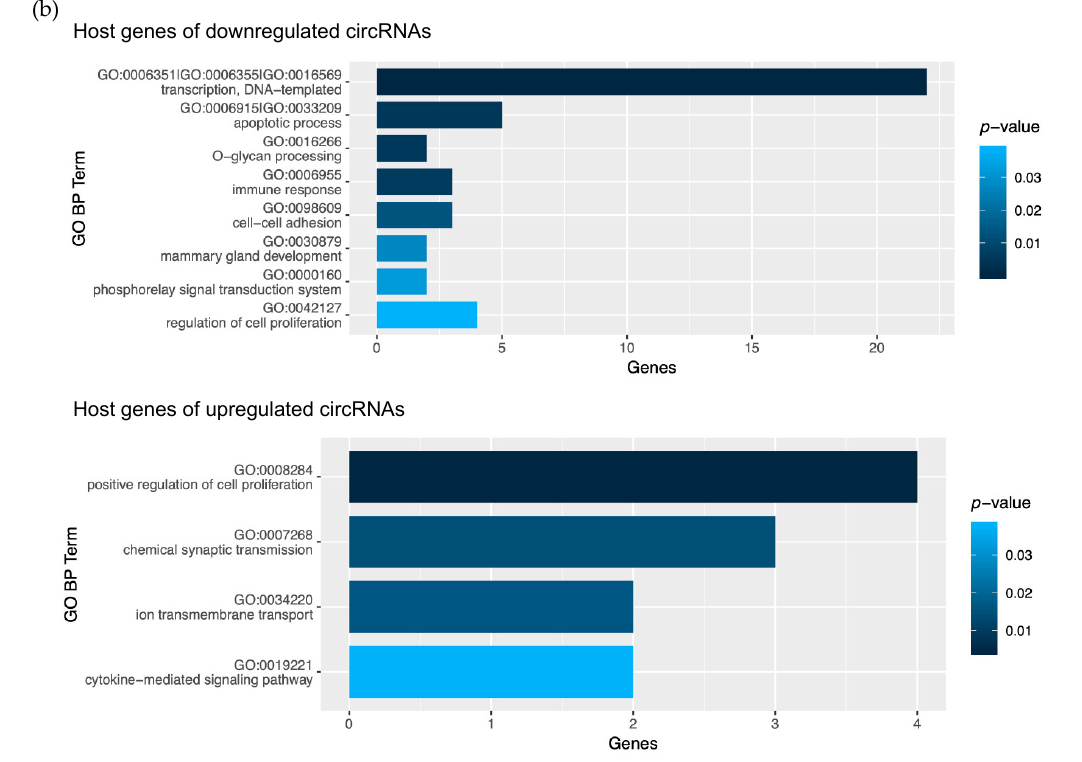
Figure 2. Effect of FUS mutation on circRNA production in mature motor neurons. ( a ) Scatter plot showing the change in the expression of circRNAs (x-axis) and their cognate linear RNAs (y-axis) in FUS P525L MNs with respect to FUS WT MNs. The distributions of the log2 fold change (FC) values are shown above and aside the scatter plot. Turquoise dots are used to indicate when only the circRNA is deregulated ( p -value < 0.05); magenta dots when only the linear RNA is deregulated ( p -value < 0.1); orange or black dots when both the circRNA and the linear counterpart are deregulated or unaffected, respectively. ( b ) Enriched GO Biological Process terms identified in the host genes of downregulated and upregulated circRNAs. The x-axis represents the number of host genes belonging to the category reported in the y-axis. Color intensity is proportional to the enrichment p -value. Redundant categories were manually clustered; when multiple GO IDs are reported, they